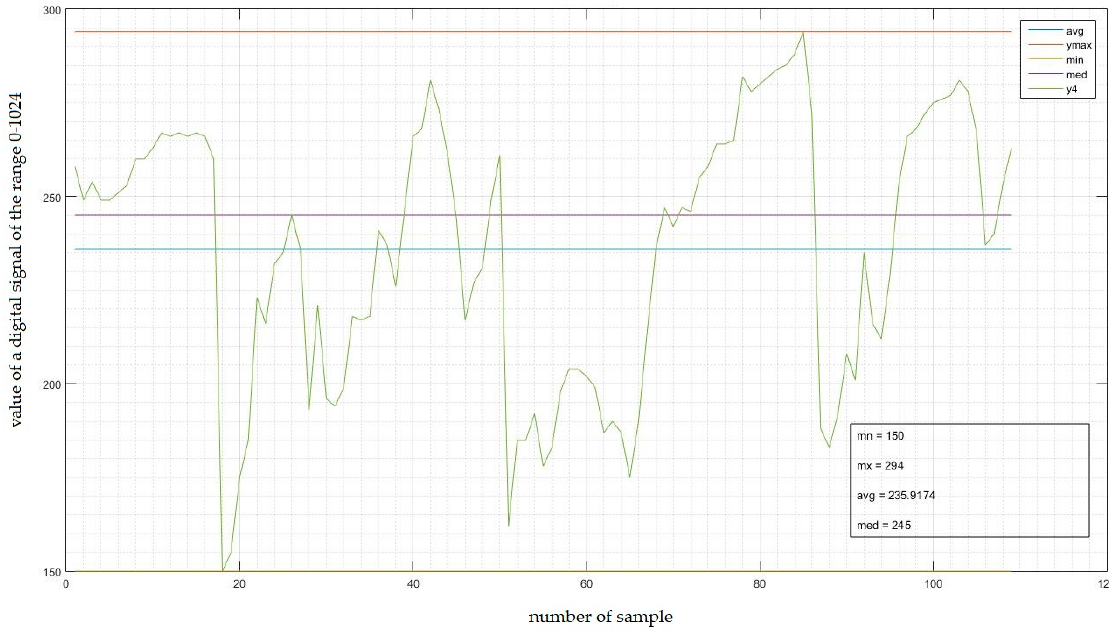
Figure A10. Data from the sensor on a straight little finger.